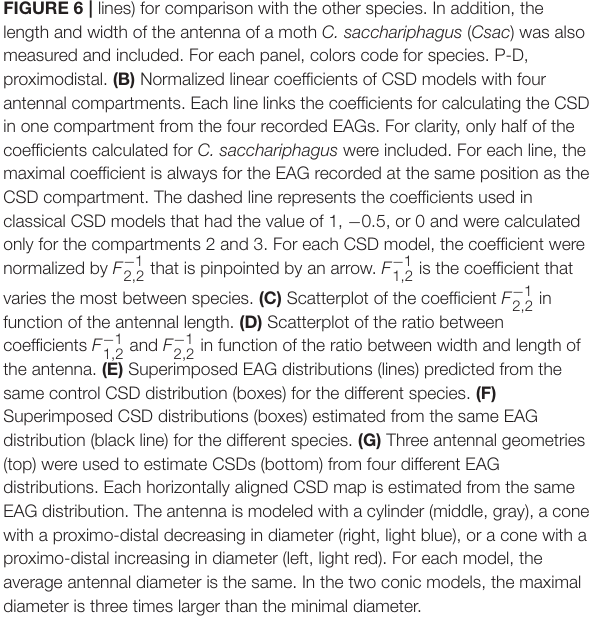
FIGURE 6 | lines) for comparison with the other species. In addition, the length and width of the antenna of a moth C. sacchariphagus ( Csac ) was also measured and included. For each panel, colors code for species. P-D, proximodistal. (B) Normalized linear coefficients of CSD models with four antennal compartments. Each line links the coefficients for calculating the CSD in one compartment from the four recorded EAGs. For clarity, only half of the coefficients calculated for C. sacchariphagus were included. For each line, the maximal coefficient is always for the EAG recorded at the same position as the CSD compartment. The dashed line represents the coefficients used in classical CSD models that had the value of 1, − 0.5, or 0 and were calculated only for the compartments 2 and 3. For each CSD model, the coefficient were normalized by F − 1 2,2 that is pinpointed by an arrow. F − 1 1,2 is the coefficient that varies the most between species. (C) Scatterplot of the coefficient F − 1 2,2 in function of the antennal length. (D) Scatterplot of the ratio between coefficients F − 1 1,2 and F − 1 2,2 in function of the ratio between width and length of the antenna. (E) Superimposed EAG distributions (lines) predicted from the same control CSD distribution (boxes) for the different species. (F) Superimposed CSD distributions (boxes) estimated from the same EAG distribution (black line) for the different species. (G) Three antennal geometries (top) were used to estimate CSDs (bottom) from four different EAG distributions. Each horizontally aligned CSD map is estimated from the same EAG distribution. The antenna is modeled with a cylinder (middle, gray), a cone with a proximo-distal decreasing in diameter (right, light blue), or a cone with a proximo-distal increasing in diameter (left, light red). For each model, the average antennal diameter is the same. In the two conic models, the maximal diameter is three times larger than the minimal